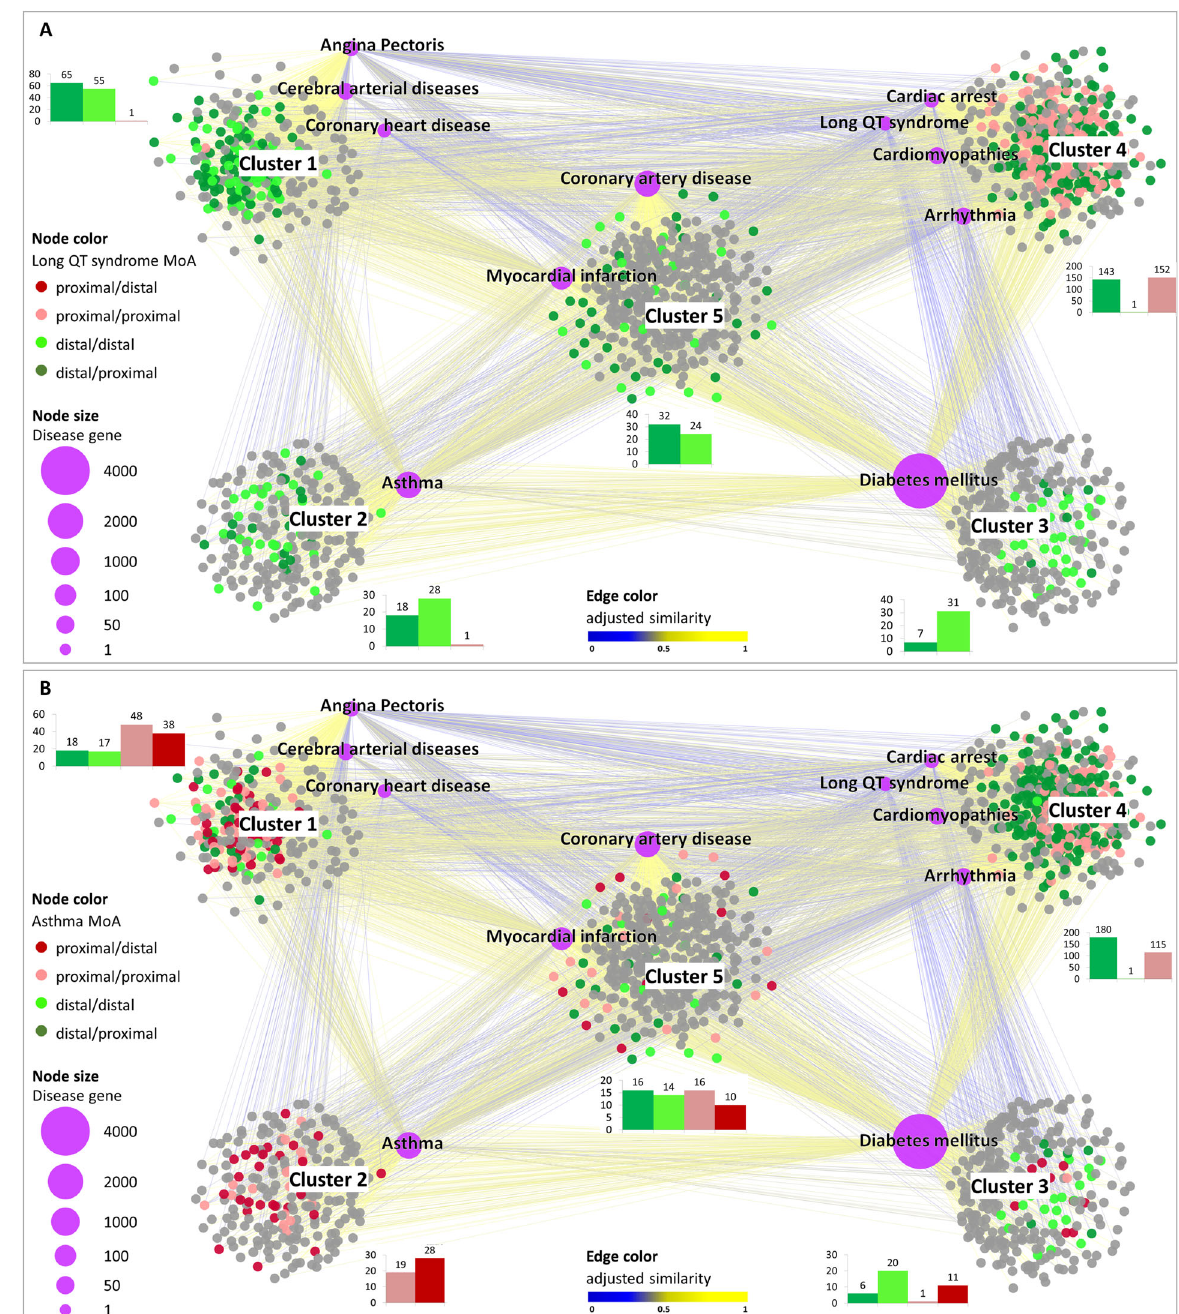
Fig. 6 Drug-disease network. This illustration shows the high-con fi dence predicted drug-disease associations connecting 11 diseases (labeled purple circles) with the 1,541 FDA-approved drugs (gray circles), where drugs are colored according their mode-of-action (MoA) with respect to long QT syndrome ( A ) and asthma ( B ) SAEs. The node size scales with the number of disease-associated genes. The edge color denotes the adjusted similarity between drug targets and disease genes in the human interactome, increasing from blue (less similar) to yellow (more similar). For the clusters identi fi cation on the drug-disease network, SAveRUNNER exploits a cluster detection algorithm based on greedy optimization of the network modularity 47 . The fi ve clusters identi fi ed by SAveRUNNER are highlighted with the corresponding labels. The bars of the histogram next to each network cluster show the count of the node types (i.e., distal/proximal, distal/distal, proximal/ proximal, proximal/distal) within that cluster and are colored according to the MoA color legend. graph (i.e., light green region in Fig. 5B left). By contrast, for cardiovascular disease, such as arrhythmia (Supplementary Fig. 5 and Supplementary Table 6). asthma, we observed a greater distribution in the adjusted This observation re fl ects a fairly glaring difference in the similarity values of drugs that populated all the four regions, intrinsic nature of the two considered side-effects. On the one corresponding to all four possible modes of drug action (Fig. 5B, hand, the long QT syndrome is a very precise phenotype, right). This pattern still holds even when considering another quantitatively measured on an electrocardiogram. In addition, npj Systems Biology and Applications (2022) 12 Published in partnership with the Systems Biology